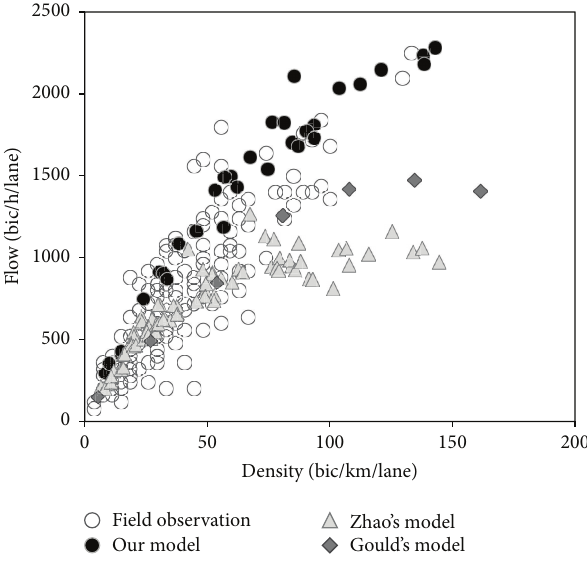
Figure 3: Comparison of flow-density